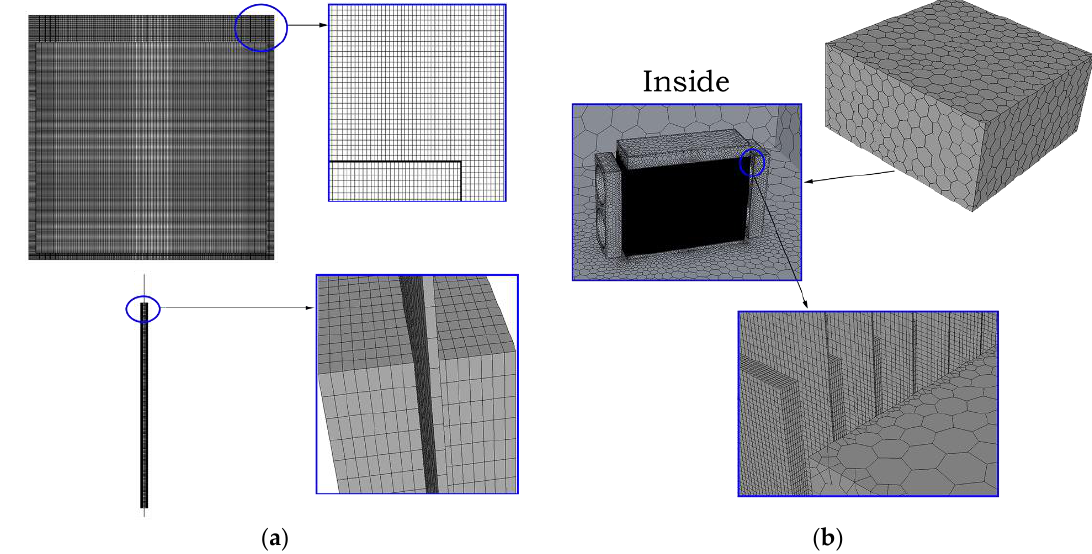
Figure 2. The grid model: ( a ) single-battery cell, and ( b ) battery module inside the fluid domain.